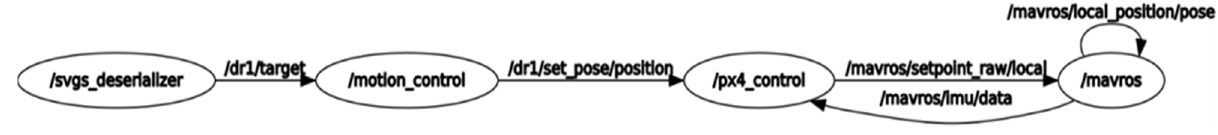
Figure 9. ROS nodes and topics for implementation of the automated landing maneuvers.